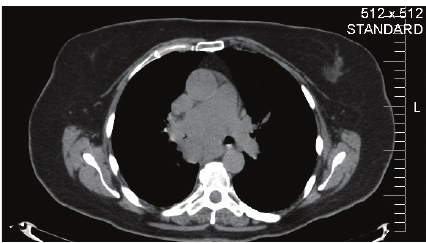
Figure 1: CT of right lung mass occluding the bronchus intermedius and a subcarinal mass which invades the left main